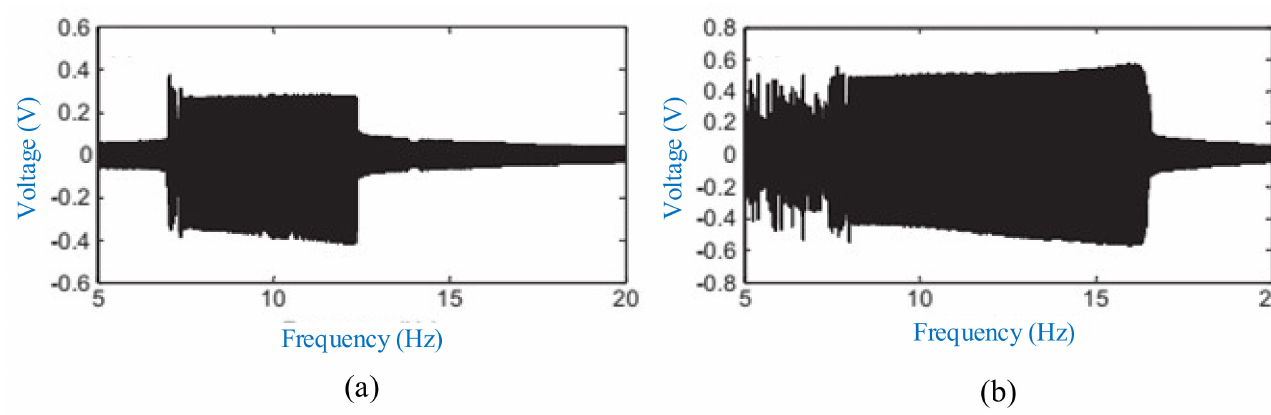
Figure 10. Tested voltages of energy harvesters under frequency-sweeping excitation. ( a ) Bistable; ( b ) quadstable (repro- duced with permission from [169]; published by Elsevier, 2016).